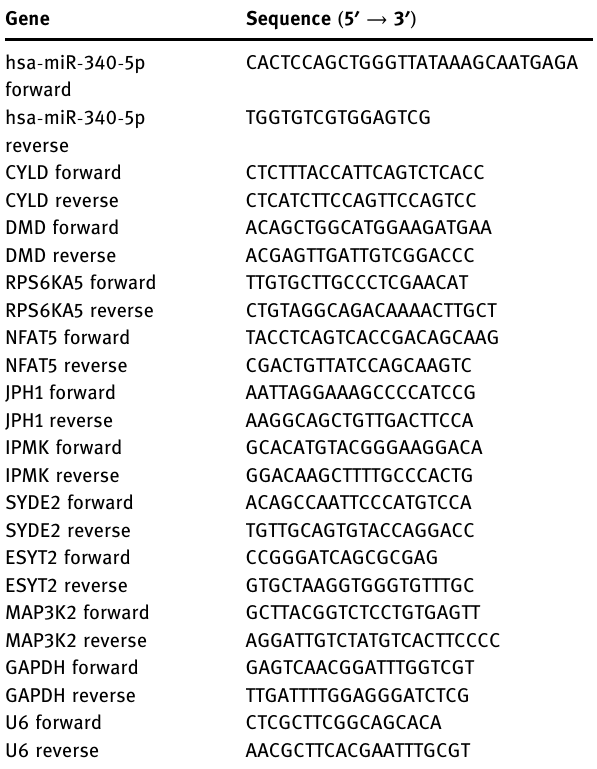
Table 1: Primer sequences used in RT - qPCR